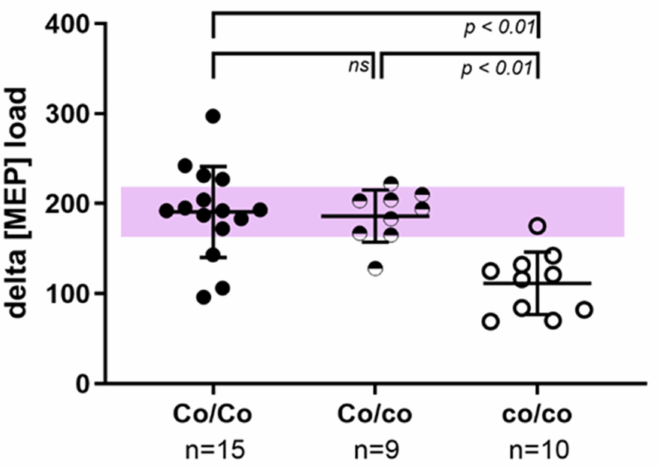
Figure 2. Platelet storage pool deficiency in cocoa dogs. Platelets of cocoa dogs ( co / co ; n = 10, white ball) present with a clearly reduced mepacrine loading capacity indicative of a lack of platelet dense granules. Heterozygous carriers ( Co / co ; n = 9, half ball) show mepacrine loading values comparable to wildtype animals ( Co / Co ; n = 15, black ball). Purple box indicates 95% confidence interval of the wildtype group. Non-parametric one-way ANOVA according to Kruskal–Wallis was used to calculate statistical significance (ns = no